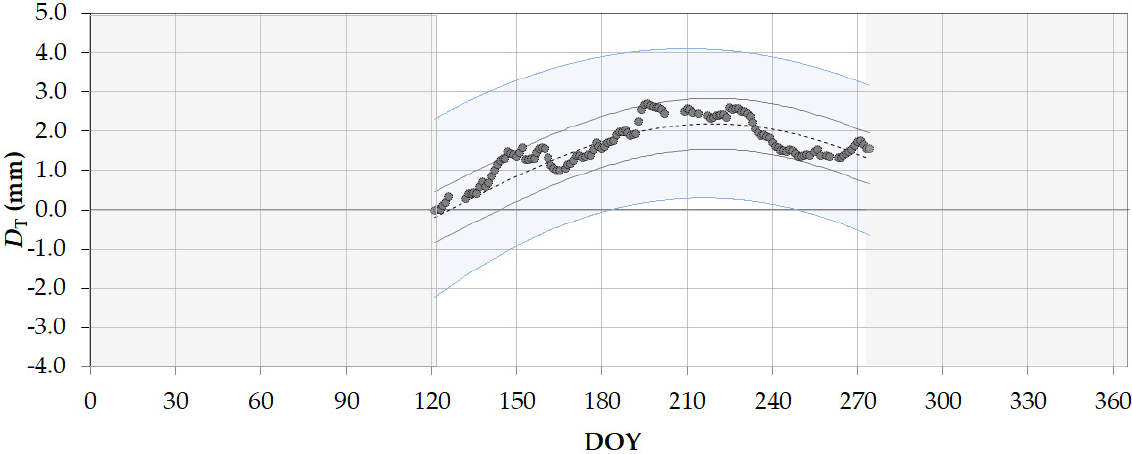
Figure 10. The temporal behaviour (DOY in x -axis) of the horizontal total displacements orthogonal to the dam ( D TOT , mm) is estimated via Global Navigation Satellite System (GNSS) (grey dots). A sinusoidal interpolation curve and confidence band of ± 2 × σ XY between measured and interpolated values (dark grey lines) are reported to facilitate the interpretation of the phenomenon (continuous line). The interpolation curves at the 10th and 90th percentiles of the raw data are reported (pale blue band) as a measure of its variability.